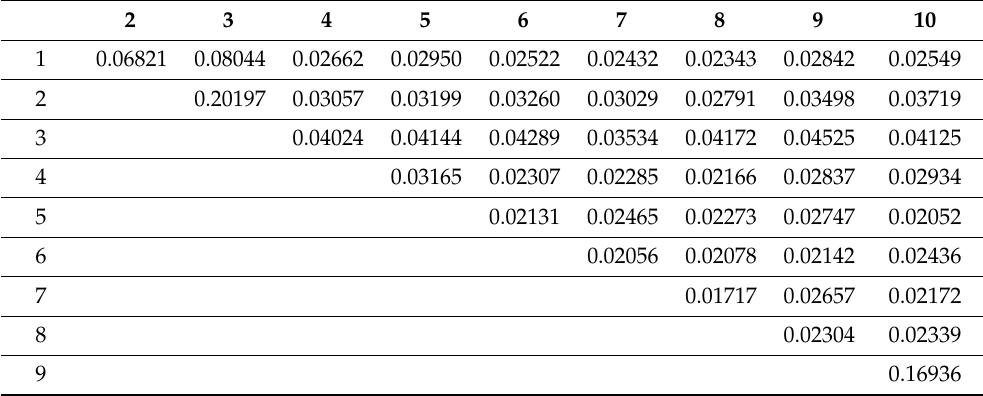
Table 5. Mean squared error of interaction coefficient estimates for LRI ( N = 1000).